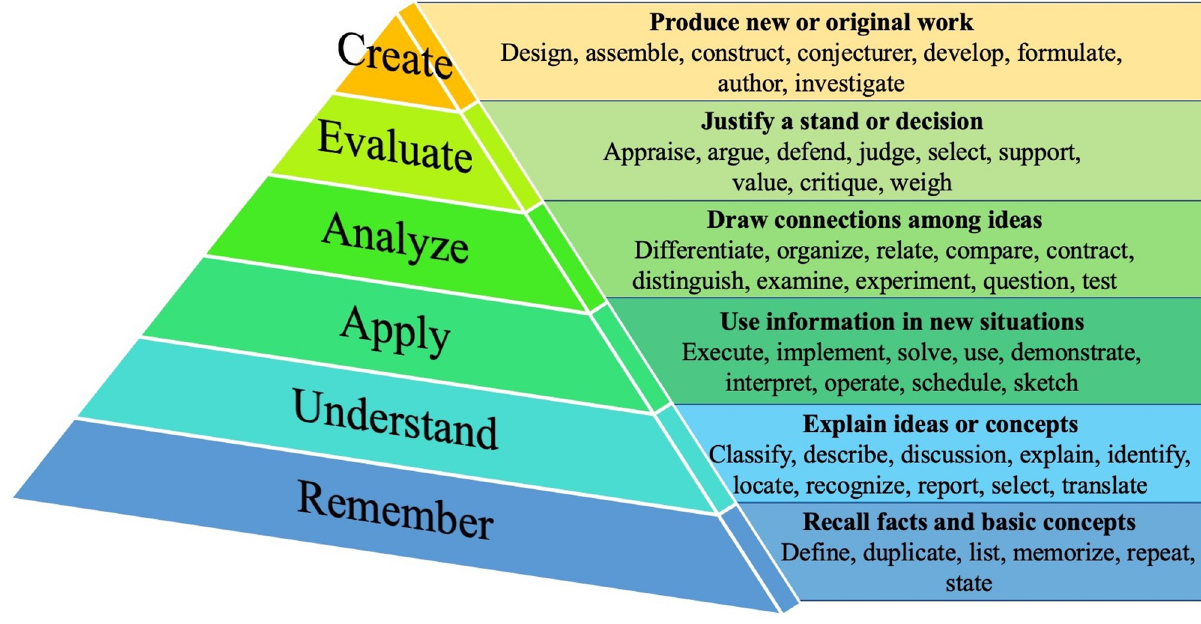
Fig 1. Levels and associated verbs for LOs in Bloom’s Taxonomy.